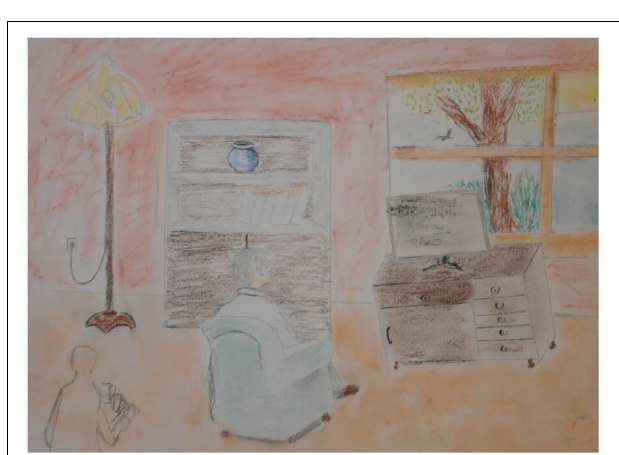
FIGURE 7 | Rearranging the room.